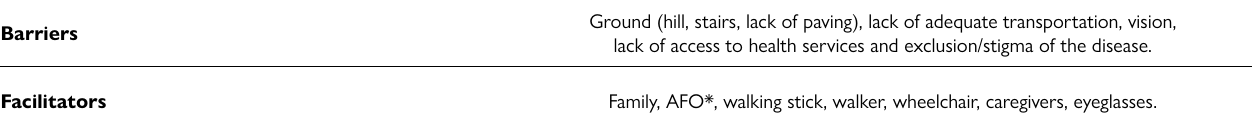
Table 4. Description of Environmental Factors of children and adolescents with MPS. Barriers Facilitators Note: AFO – ankle-foot